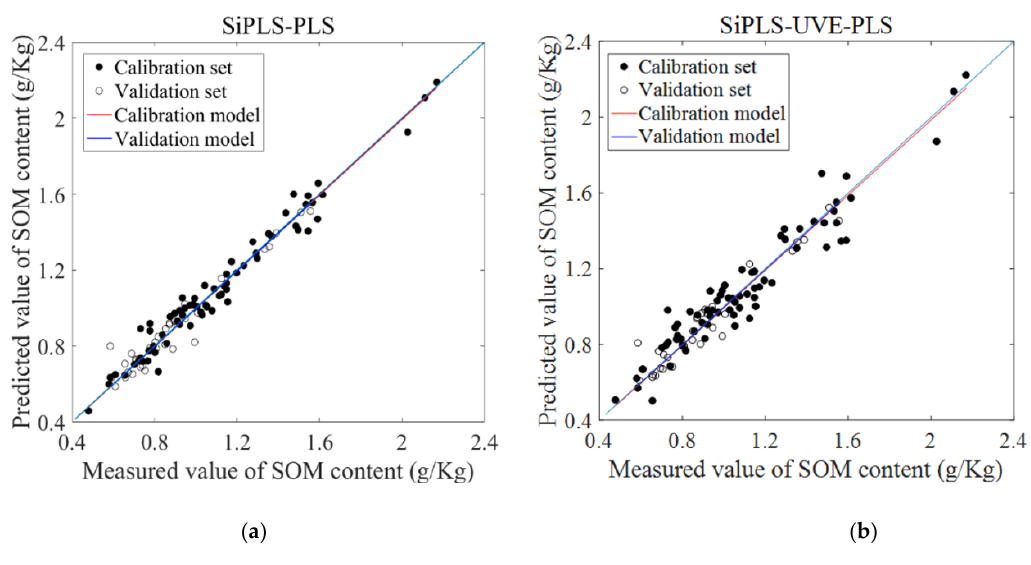
Figure 8. Prediction model of the SOM content based on VIS-NIR. ( a ) SiPLS-PLS prediction model of SOM content and ( b ) UVE-SiPLS-PLS prediction model of the SOM content.